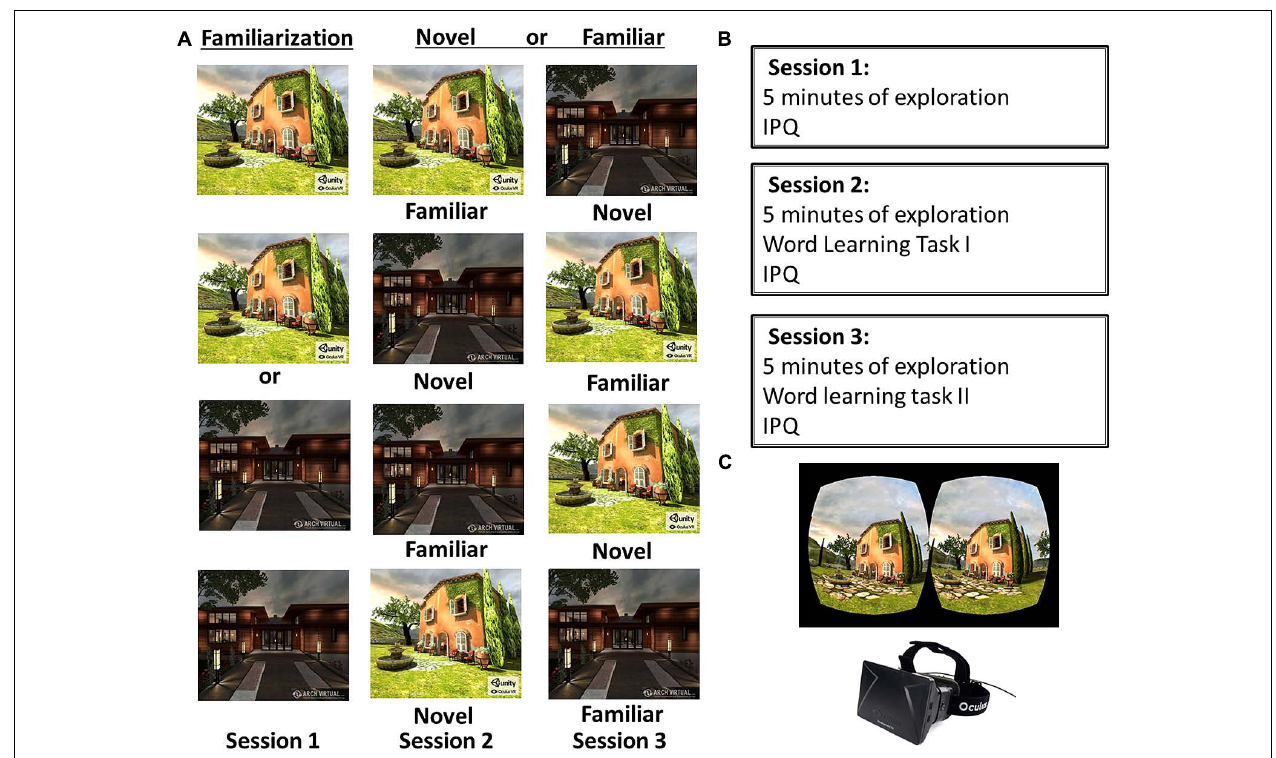
FIGURE 1 | Experimental design and apparatus. (A) In session 1 participants were familiarized either withTuscany or the Residential virtual environment (VE). In session 2 they either explored the familiarizedVE (Familiar First) or the novelVE (Novel First). In the final session 3, participants in the Novel First condition explored the familiarVE, and participants in the